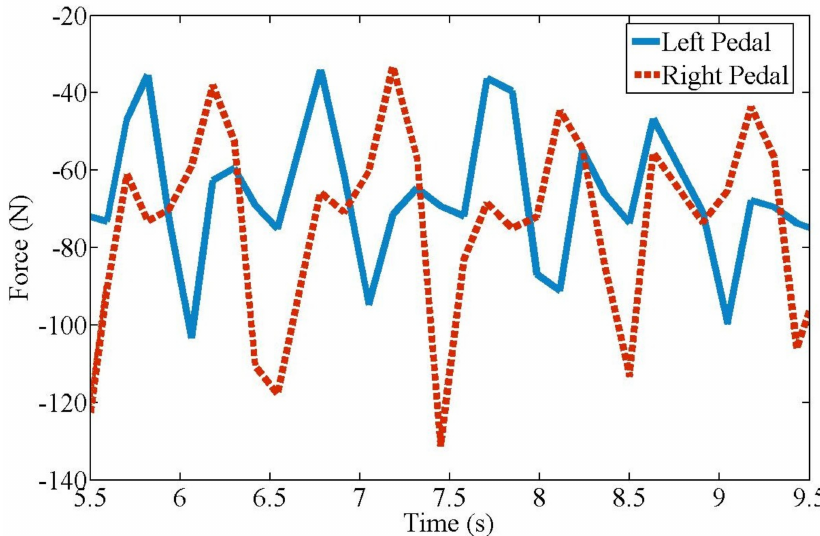
Figure 7. Forces on pedal during experimentation as shown in Figure